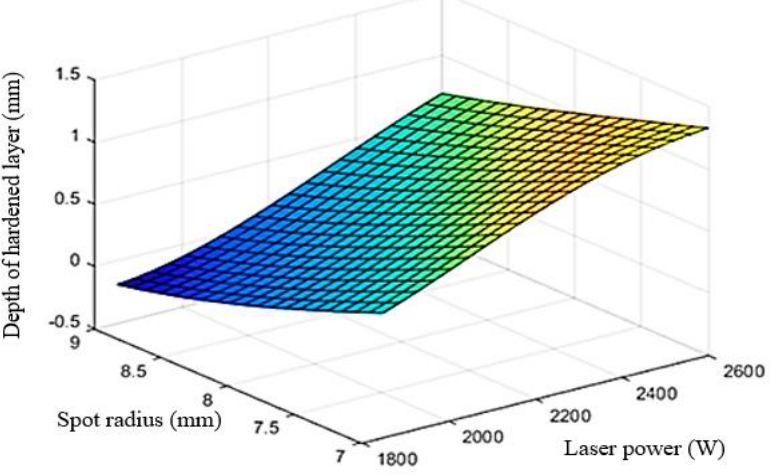
Figure 11. Kriging models for depth of hardened layer of laser power and spot radius.